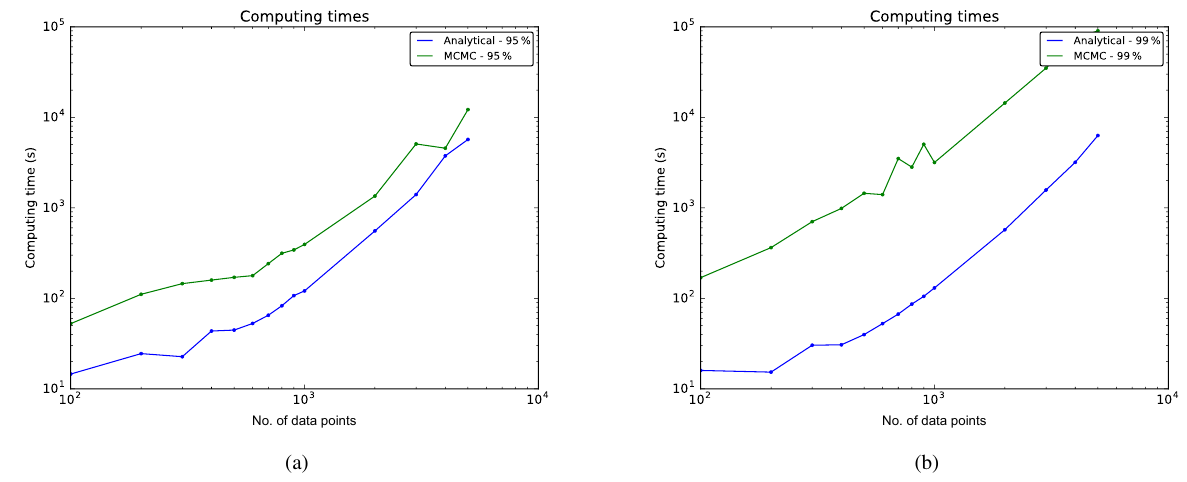
Figure G1. Computing times for generating the scalogram with analytical (blue) and MCMC (green) confidence levels, in function of the number of data points (disposed on a regular time grid). Log–log scale. (a) 95th percentiles. (b) 99th percentiles.